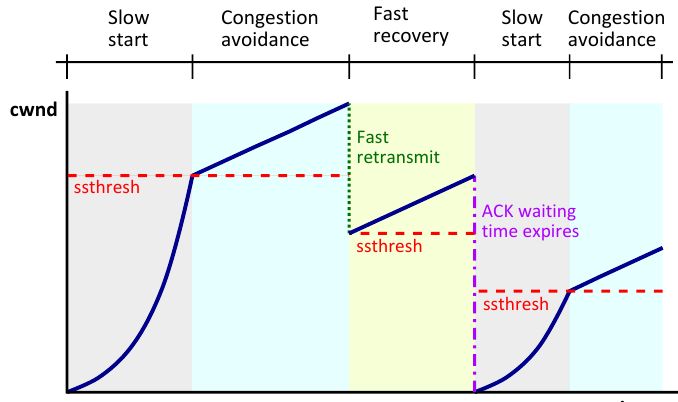
Figure 3. TCP congestion control